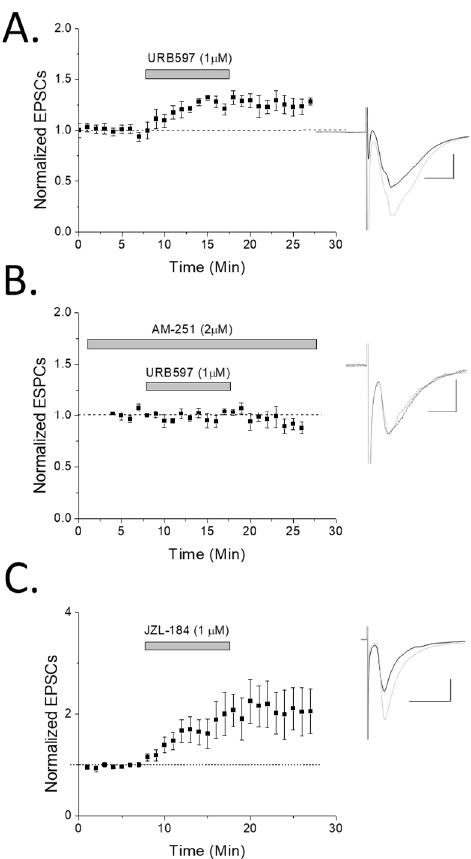
Figure 3. Fatty acid amide hydrolase (FAAH) inhibition potentiates rat hippocampal oriens interneurons in a CB1-dependent manner. ( A ) Stratum oriens interneurons were patched ( n = 8) in whole cell voltage-clamp mode and recorded while the enzyme FAAH was inhibited by URB-597 (1 µ M). A significant ( p < 0.05; ANOVA) potentiating effect was observed, suggesting a role of anandamide in oriens synaptic plasticity. ( B ) CB1 antagonist AM-251 significantly blocked FAAH-induced potentiation ( n = 7; p < 0.05; t test, comparing URB-597 to URB-597 + AM-251). ( C ) The monoacylglycerol lipase (MAG lipase) inhibitor, JZL184 (1 µ M), used to prevent degradation of 2-AG also resulted in significant ( p < 0.05; ANOVA; n = 5) enhancement of EPSC responses (individual cells were examined for significance in their potentiation by ANOVA and included if significant). Note that of the six significantly potentiating cells (of nine recorded from), four were confirmed SOM+ by posthoc PCR analysis while two were unclassifiable. Inset: traces were taken of 10–12 sweeps just before HFS (black) or ~15 min post-drug application (light gray).